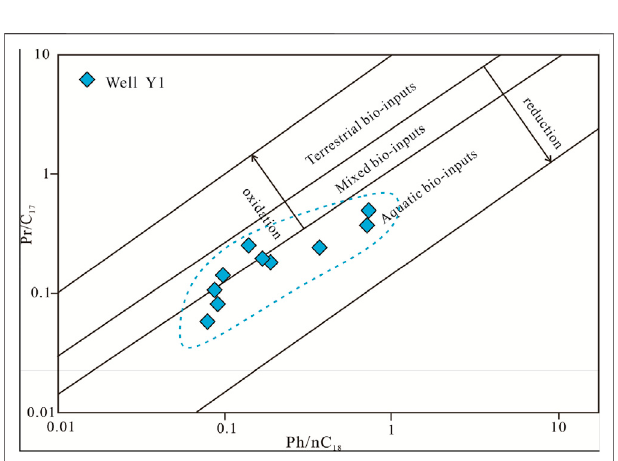
FIGURE 10 | Typical hopanes chromatograms of J 1 da shale samples.